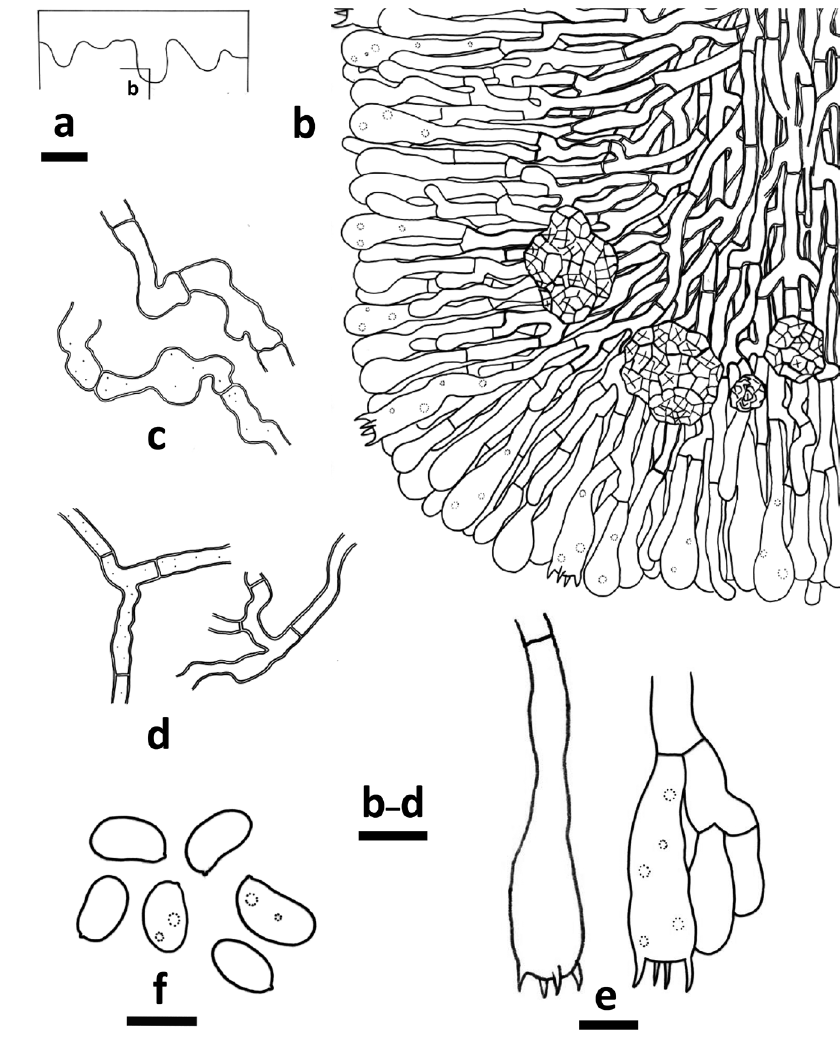
Figure 5. Odontoefibula orientalis (holotype, Wu 0910-57 ) a Profile of basidiocarp section b Part of the vertical section of trama c Basal hyphae d Subicular hyphae e Basidia f Basidiospores. Scale bars: 200 μm ( a ); 10 μm ( c–d ) ; 5 μm ( e–f ) dark reddish in KOH, slightly tuberculate when young, becoming odontioid with age, extensively cracked; margin paler, thinning out, slightly filamentous. Aculei conical to cylindrical, usually fused at the base, with rounded to obtuse apex, 3–6 per mm, ca. 0.1–0.3 × 0.1–0.2 mm. texture, 200–300 μm thick; subicular hyphae somewhat vertical, colourless, 2.5–4 μm diam., 0.5–0.8 μm thick walls; hyphae near substratum interwoven, with irregular ori-